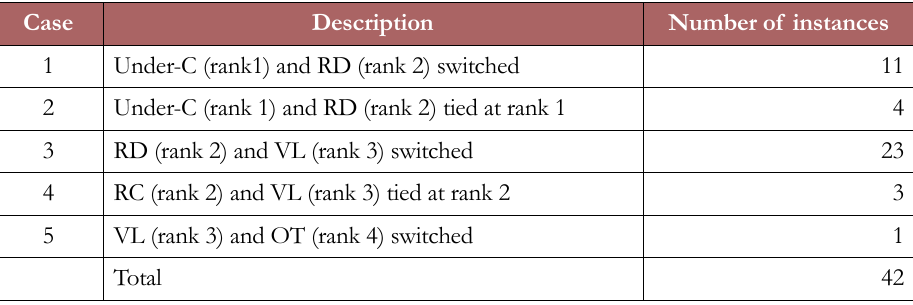
Table 12. Cases and number of instances of changed rankings